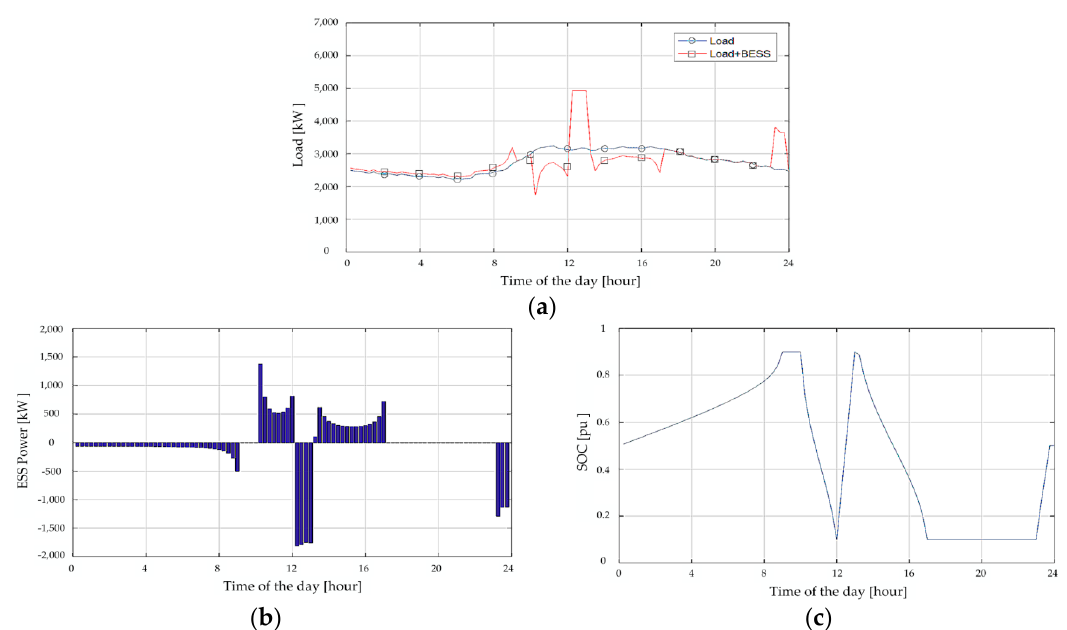
Figure 11. Case 3 simulation results. ( a ) Comparison of the original load and the load after ESS